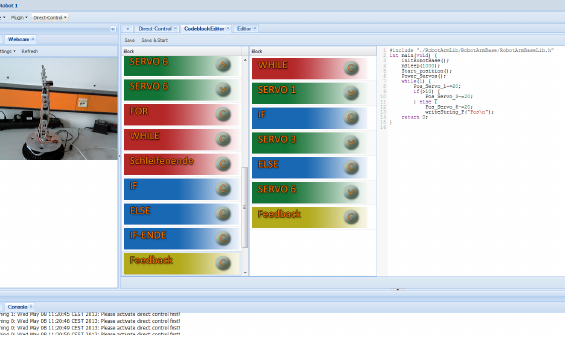
Figure 3. Fragment of Manipulator Lab user